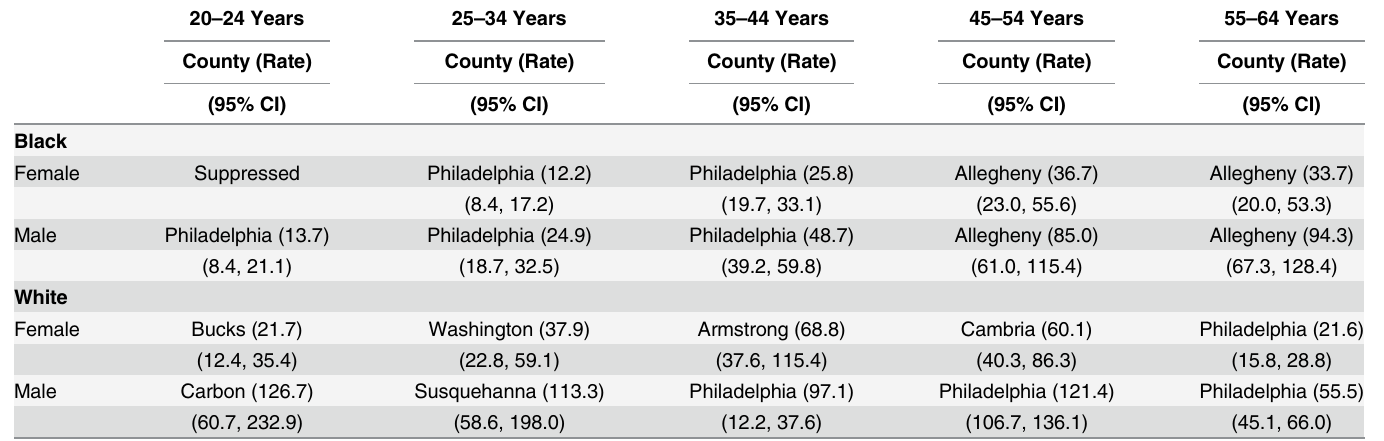
Table 2. PA County with Highest 2010 – 2014 Accidental Poisoning Mortality Rate by Race, Sex, and Age